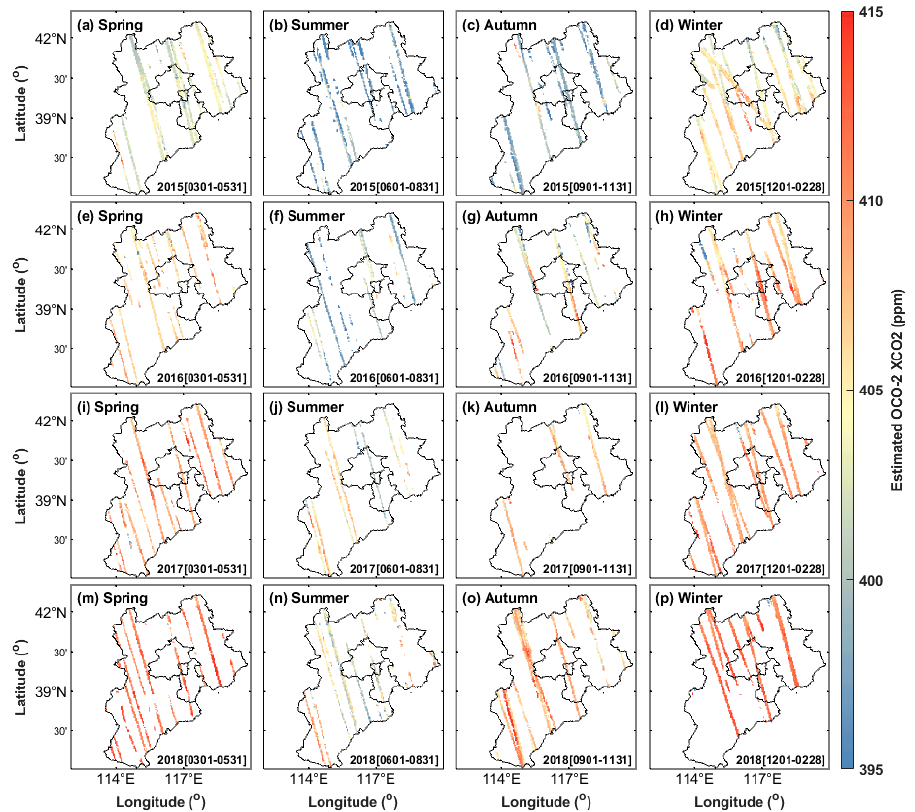
Figure 7. Seasonal means of OCO-2 XCO 2 L2 Lite_FP data during 20150301–20190228, all resampled to 0.05° × 0.05° spatial resolution: ( a – d ) 2015, ( e – h ) 2016, ( i – l ) 2017, and ( m – p ) 2018 in spring, sum- mer, autumn, and winter,